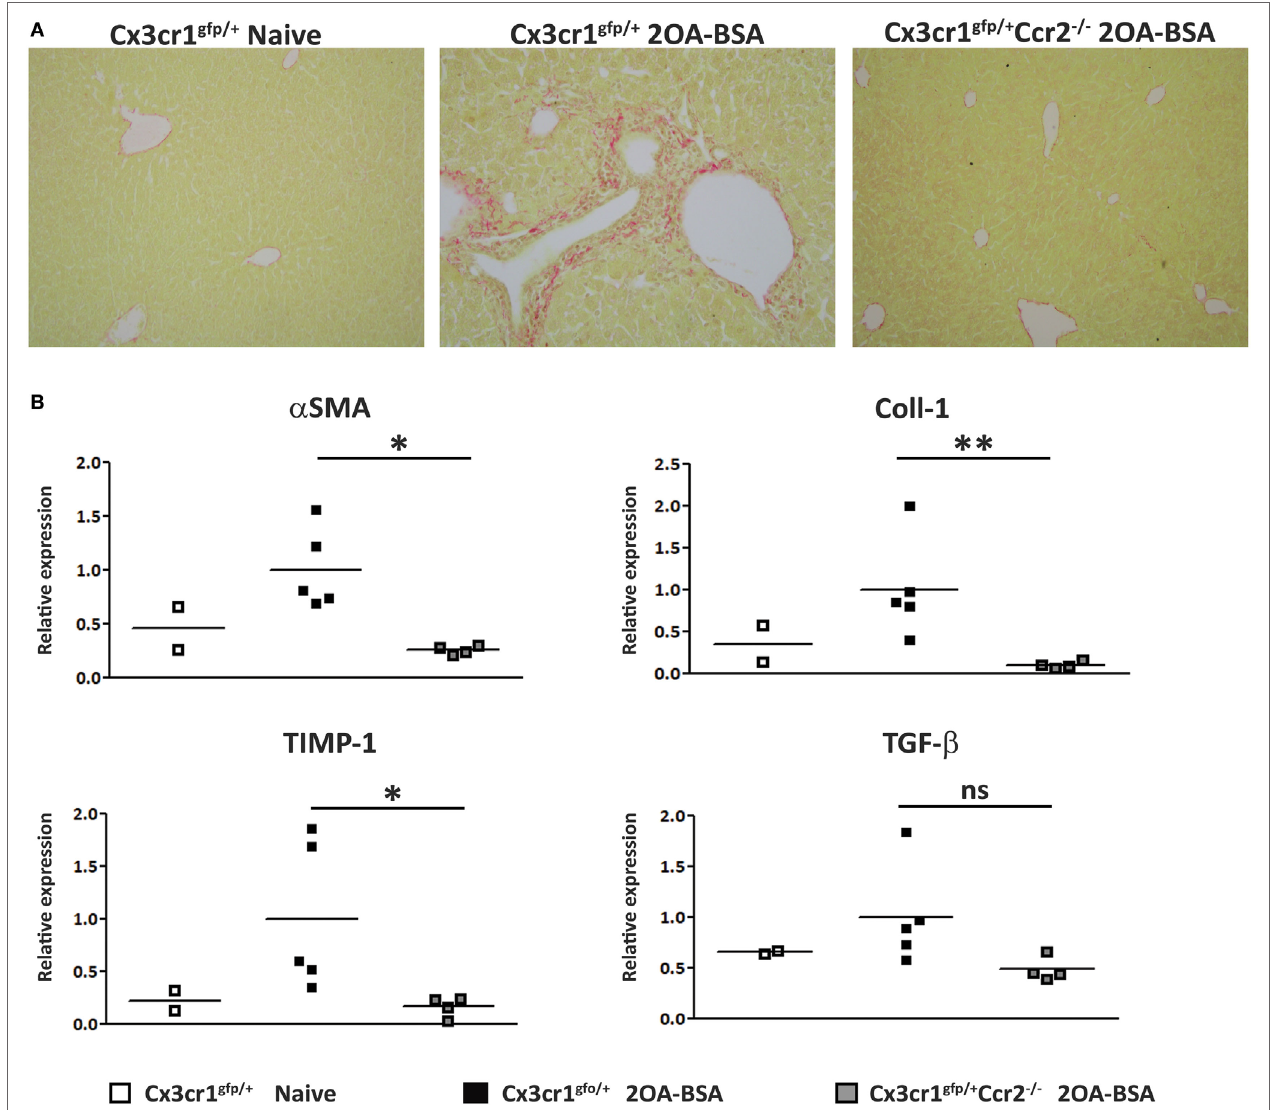
FigUre 3 | C-C motif chemokine receptor 2-deficient mice are protected from the development of fibrosis in the 2-octynoic acid conjugated to bovine serum albumin (2OA-BSA) autoimmune cholangitis model. (a) Representative liver sections from indicated mice—Picro-Sirius red staining. (B) Graphical summary of hepatic expression levels of fibrosis-associated genes of indicated mice. All data are presented as mean, n ≥ 5 per experimental group. Results are representative of three or more independent experiments. * p < 0.05 and ** p < 0.01 (unpaired Student’s t